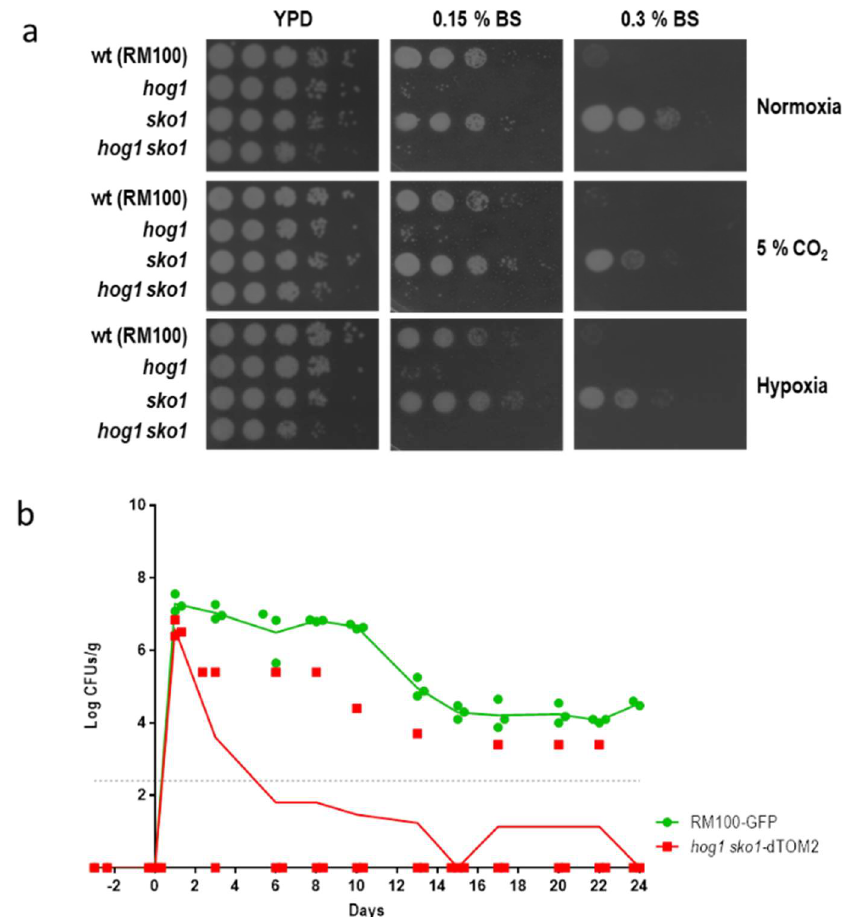
Figure 2. Influence of SKO1 deletion in a hog1 background. a) ten-fold dilution of cell suspensions of the indicated strains were spotted on YPD plates that were supplemented with different amounts of Bile Salts (BS). Plates were incubated under the specified conditions at 37 °C for 24 h (normoxia and 5% supplemented CO 2 atmosphere) or 48 h (for plates incubated under hypoxia). b) C57BL/6J mice that were pre-treated with antibiotics were inoculated with a balanced mix of wt-GFP/ hog1 sko1 -dTOM2 cells and colonization was followed across time. The graph represents Log CFUs/ g of faeces versus time. Each square represents a single mouse ( n = 3).